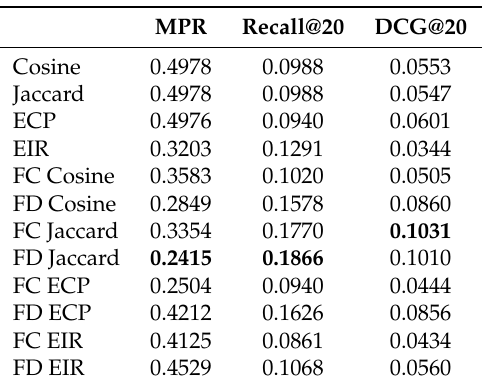
Figure 10. Recall@20 as the function of item support for the Netflix data set. Table 8. Experiments with combination of collaborative filtering for the first quantile (based on KDE estimation of 25%) of the MovieLens data. Best performing methods are indicated in